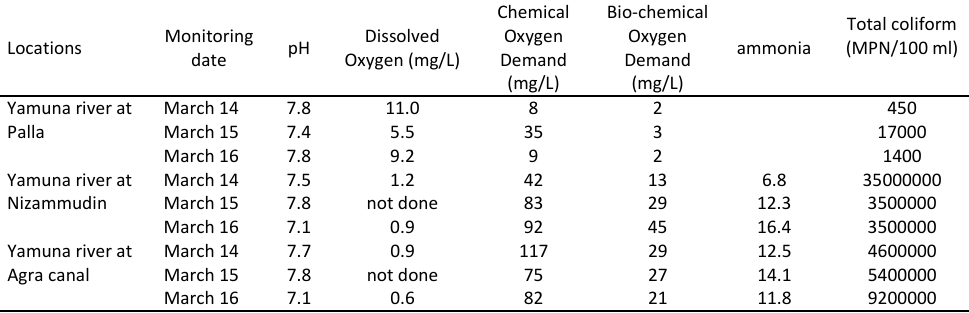
Table1: Comparative figures showing quality of water during March 2014 ‐ 15 ‐ 16 (WQSRY, 2016)